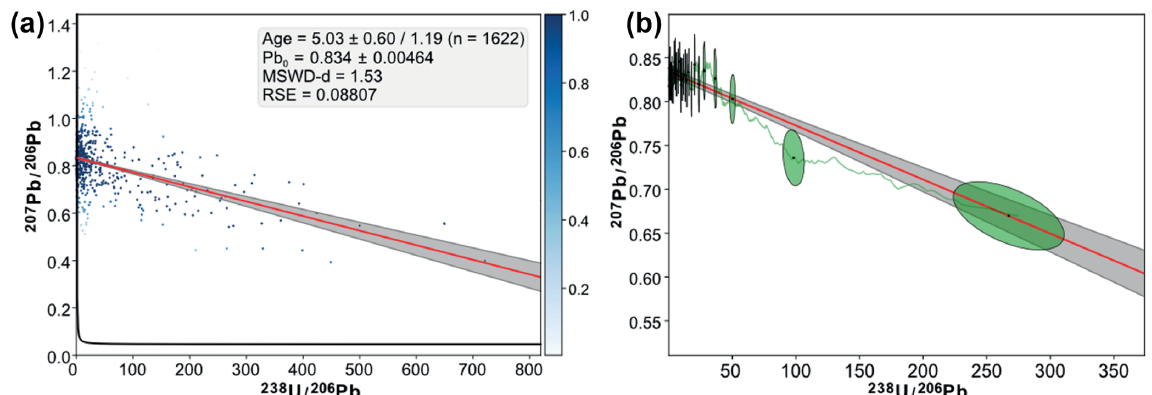
Figure 9. (a) Tera–Wasserburg concordia plot obtained from LA-ICPMS U–Pb dating of FAB5 calcite sample. The age was obtained by robust regression through the U–Pb image pixel values. The scale bar corresponds to the weight of each pixel as determined by robust regression. (b) Same plot but with discretized data represented as ellipses (one ellipse = 60 pixels). The running mean (window = 60 pixels) is also shown as a green